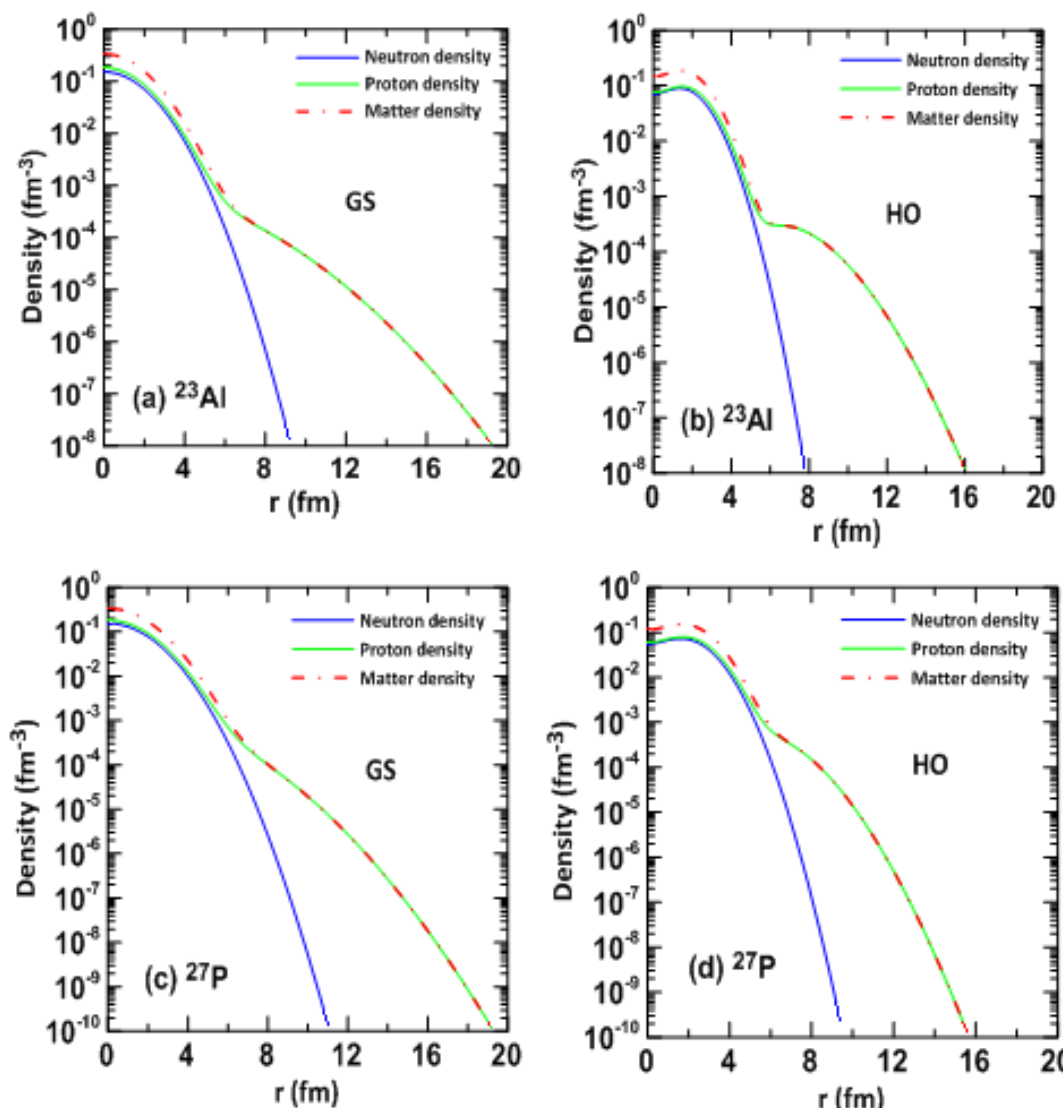
Fig. 3: The neutron, proton and matter density distributions for halo nuclei 23 Al and 27